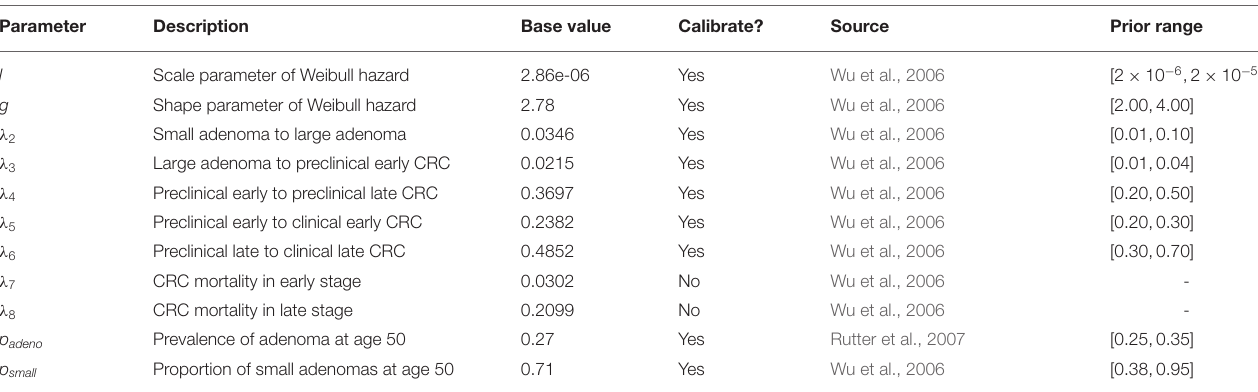
TABLE 2 | The parameters of the natural history model of colorectal cancer